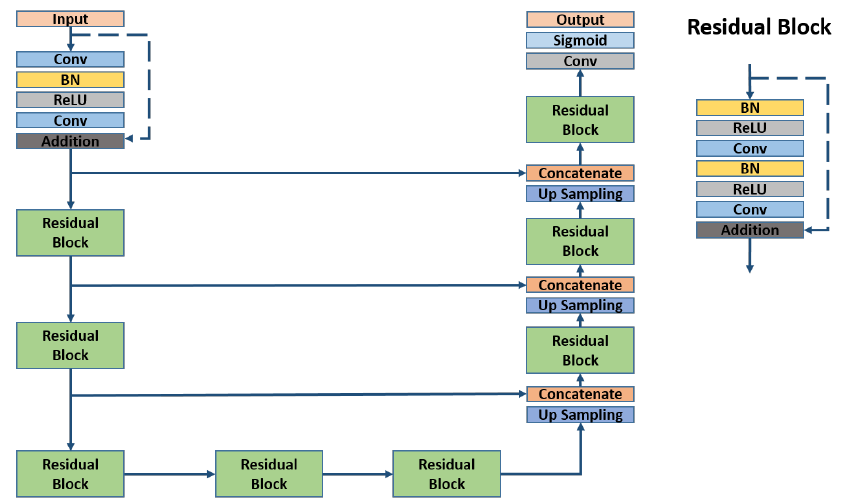
Figure 2. Residual U-net for building